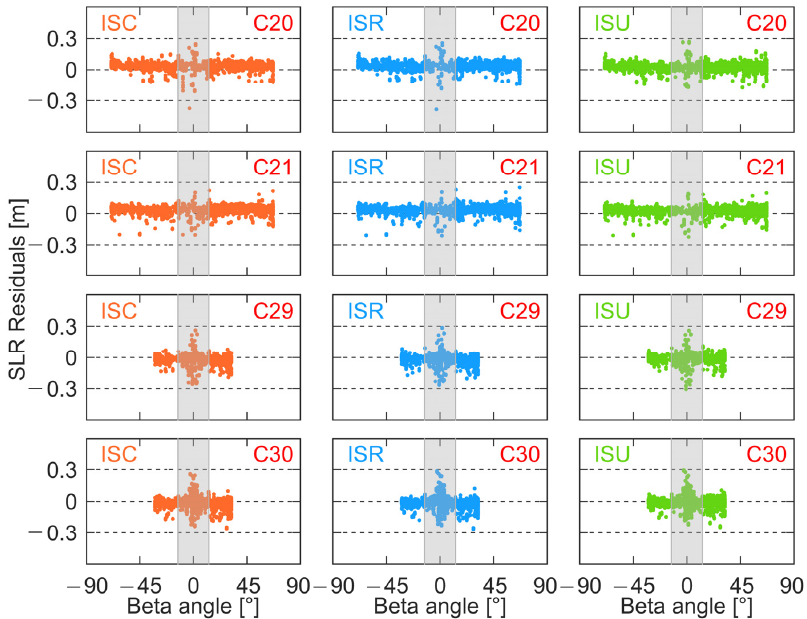
Figure 16. SLR residuals of BDS-3 satellites based on three types of iGMAS B1I/B3I orbits versus beta angle.